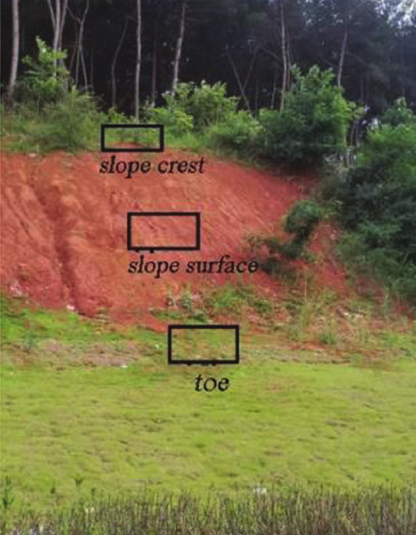
Figure 1: Test slope.